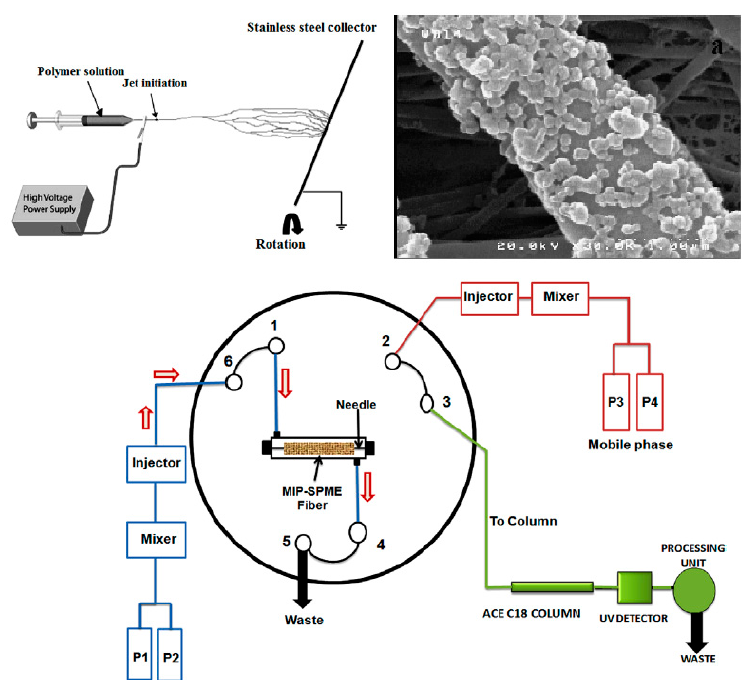
Figure 5. Schematic method using MIP nanofiber preparation, structure and operation [46].